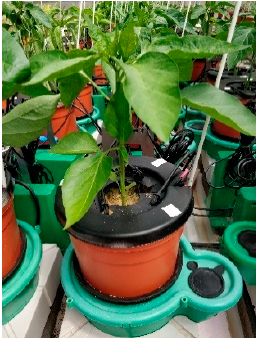
Figure 1. A pot in the greenhouse. Four drippers provided the water and nutrients, while evaporation was restricted with a plastic cover. The pot was loaded onto a green plastic container that collected a predetermined amount of drainage. The pot and plastic container were placed on a scale which is connected to Plantarray 3.0 system.